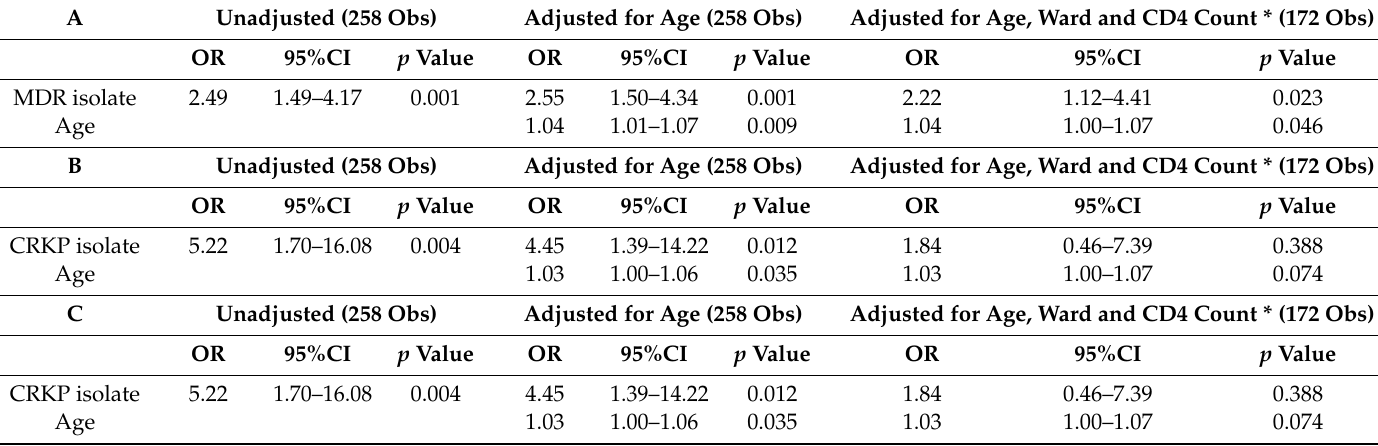
Table 3. A: Multivariable GEE models for factors associated with mortality in the entire population; B: CRKP isolate subanalysis; C: MRSA isolate subanalysis. A Unadjusted (258 Obs) Adjusted for Age (258 Obs) Adjusted for Age, Ward and CD4 Count * (172 Obs) OR